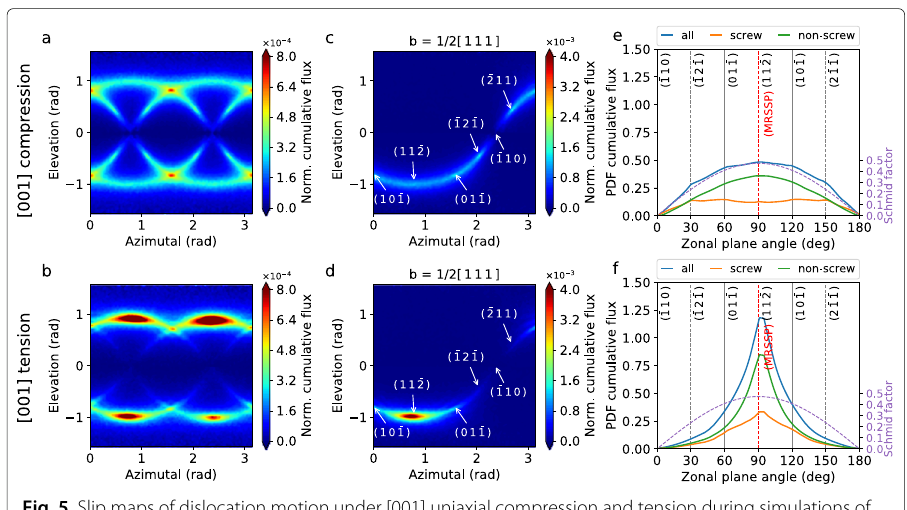
Fig. 5 Slip maps of dislocation motion under [001] uniaxial compression and tension during simulations of bulk plasticity. a – b Maps of the cumulative dislocation flux γ from all dislocations from strain 0.5 to 1. c – d [111] dislocations alone. Positions of relevant Maps of the cumulative dislocation flux from the 1 2 crystallographic slip planes along the [111] zone are indicated. e – f Probability distribution of slip facets area (cid:4) 111 (cid:5) dislocations. The flux is further partitioned into as a function of the (cid:4) 111 (cid:5) zonal plane angle for all 1 2 screw and non-screw dislocations contribution, where non-screw dislocations correspond to facets with character angle θ ≥ 20 ◦ . The thin dashed line is the Schmid factor variation over the zone with its scale shown on the right